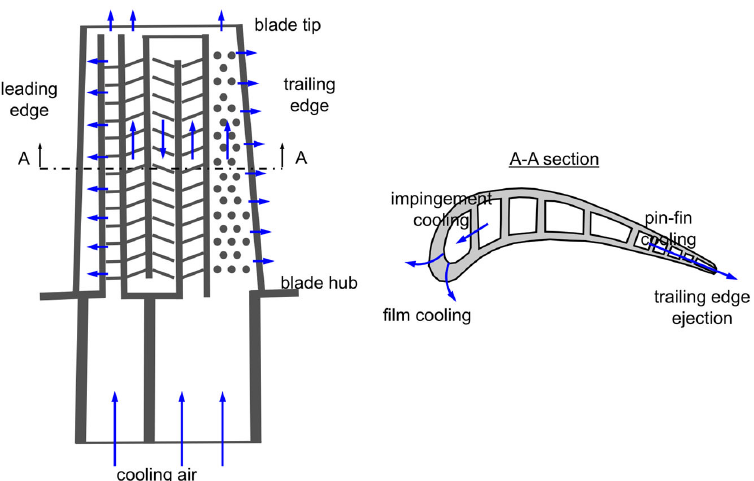
Figure 1. Typical turbine blade internal cooling system.